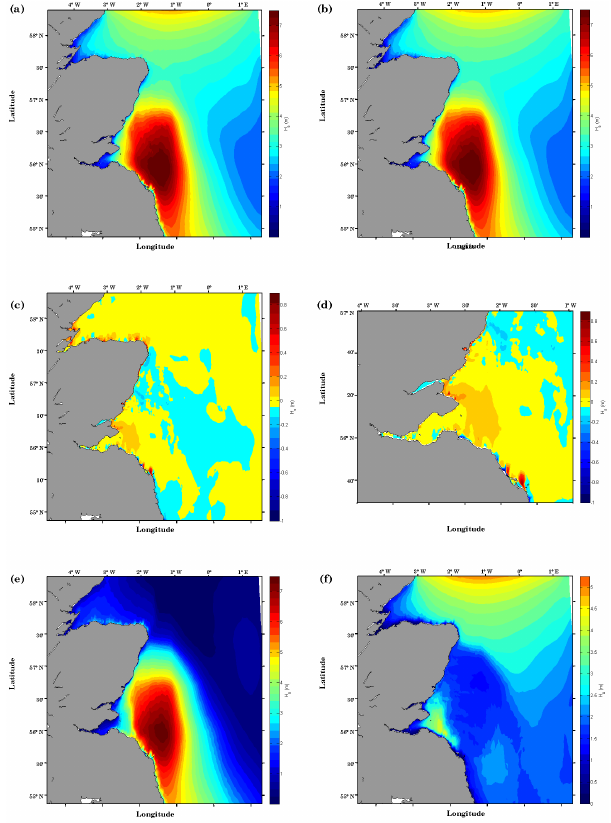
Figure 14. The modelled H s on the east coast of Scotland at 00:30UTC on 31 March 2010: (a) coupled model (mean WCI in- cluded), (b) uncoupled model (mean WCI not included), (c) dif- ference between coupled and uncoupled models, (d) difference be- tween coupled and uncoupled models in the Firth of Forth area, (e) windsea waves, (f) swell waves.